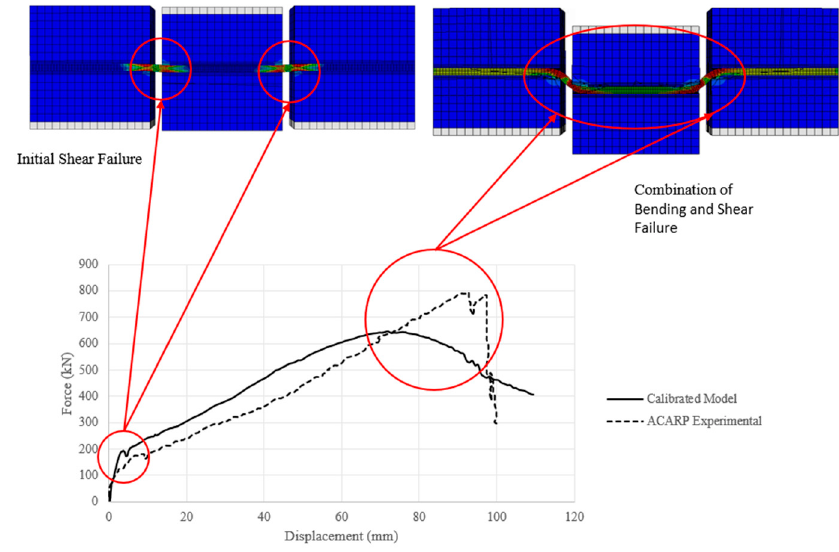
Figure 10. Static calibration model deflection behaviour.